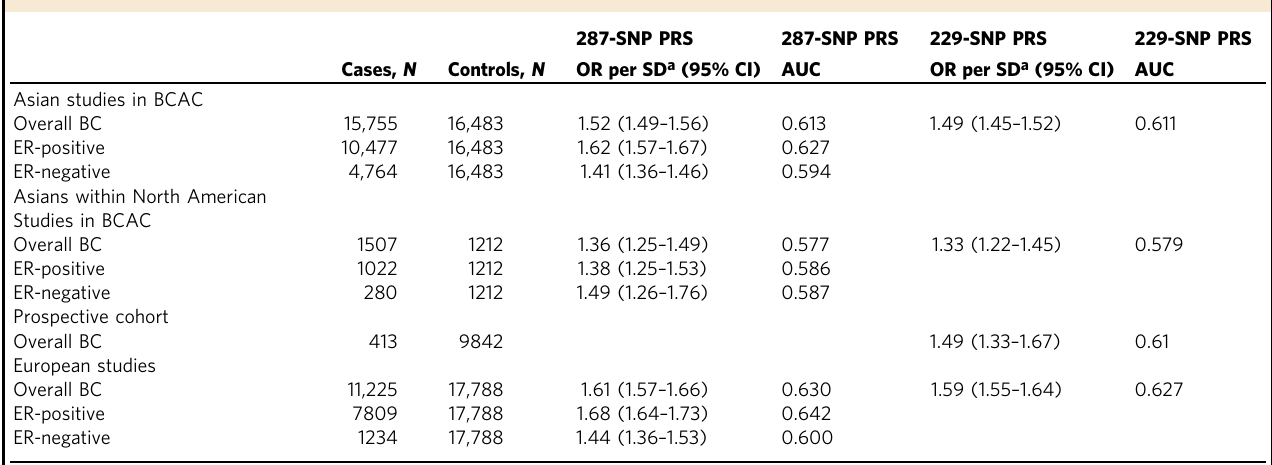
Table 2 Association between standardised polygenic risk scores and breast cancer risk.